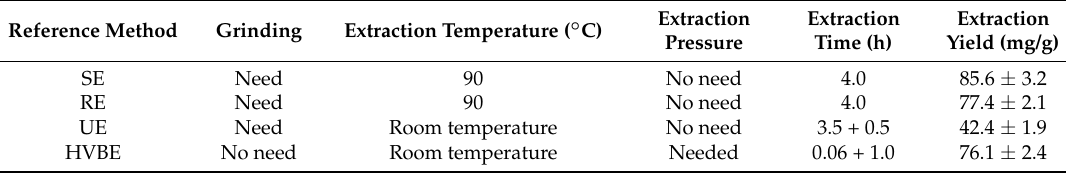
Table 1. Compared with the reference extraction methods of flavonoids.